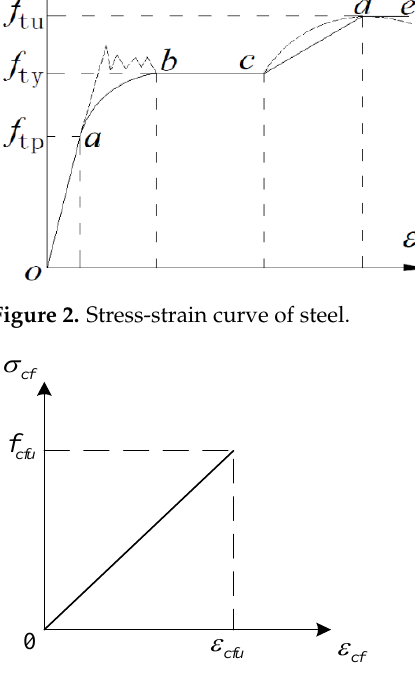
Figure 3. Stress-strain curve of CFRP sheet.